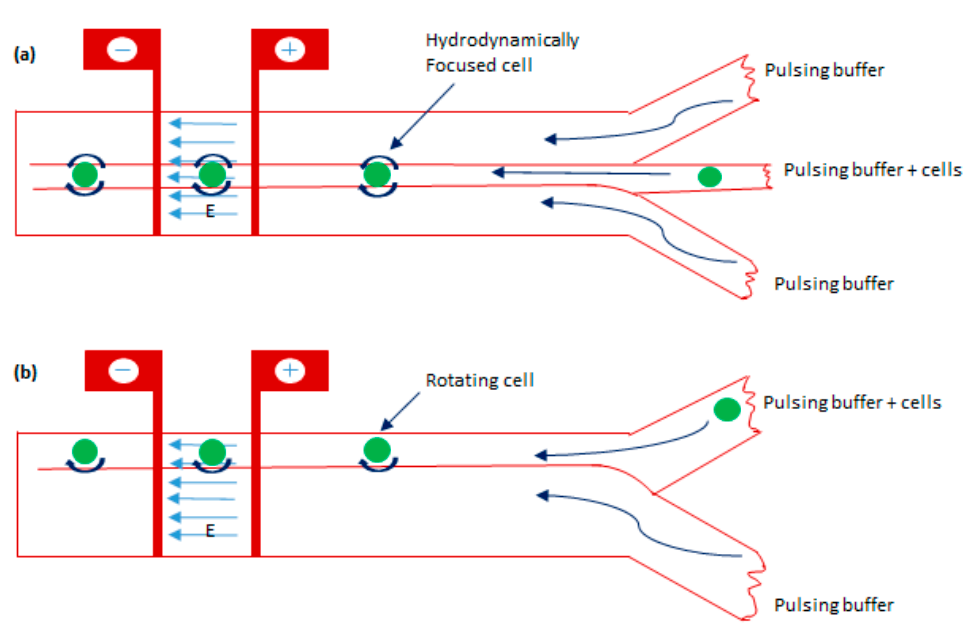
Figure 13. The schematic diagram of the electroporation technique is based on cell rotation with two configurations. ( a ) A microchannel having three inlets with cell carrier flows being hydrodynamically focused between two sheathing flows. ( b ) A microchannel having two inlets with electroporating electrodes across the channel. Figure has been redrawn from ref. [112].